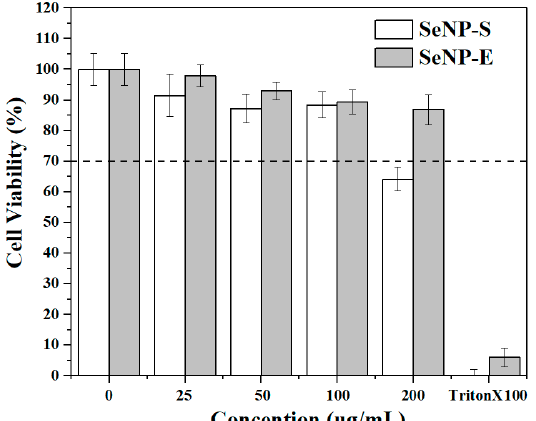
Figure 8. Cytotoxicity of SeNPs-E and SeNPs-S. Data were averaged across three replicates, with corresponding standard deviations.